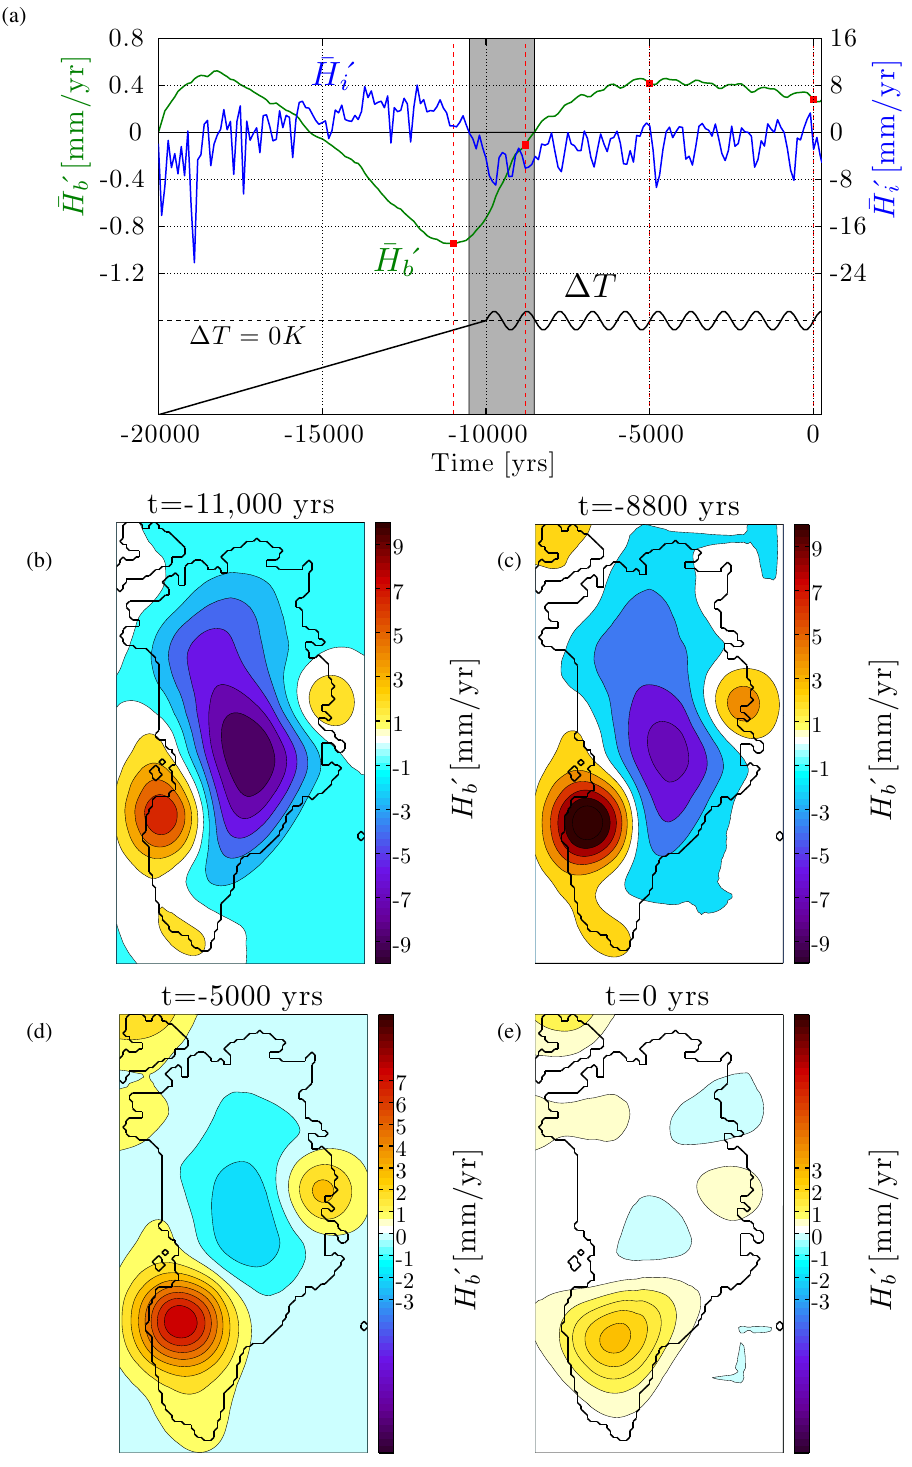
Fig. 2. (a) Time evolution of the spatial average ¯ H 0 and ¯ H 0 for a forcing that simulates the last deglaciation and 10000yr of the Holocene. Once the ice thins (negative values of ¯ H 0 ), the bedrock reacts with uplift with a lag of 1990yr. The grey area shows a period when thinning of the ice is present as well as bedrock subsidence. (b–e) Spatial patterns of bedrock elevation changes for the selected red squares in (a) for: (b) the maximum subsidence, (c) a moment when ice thinning and bedrock subsidence exist simultaneously, (d) a moment when ¯ H 0 positive (bedrock uplift), and (e) PD conditions, characterized by an average bedrock uplift.